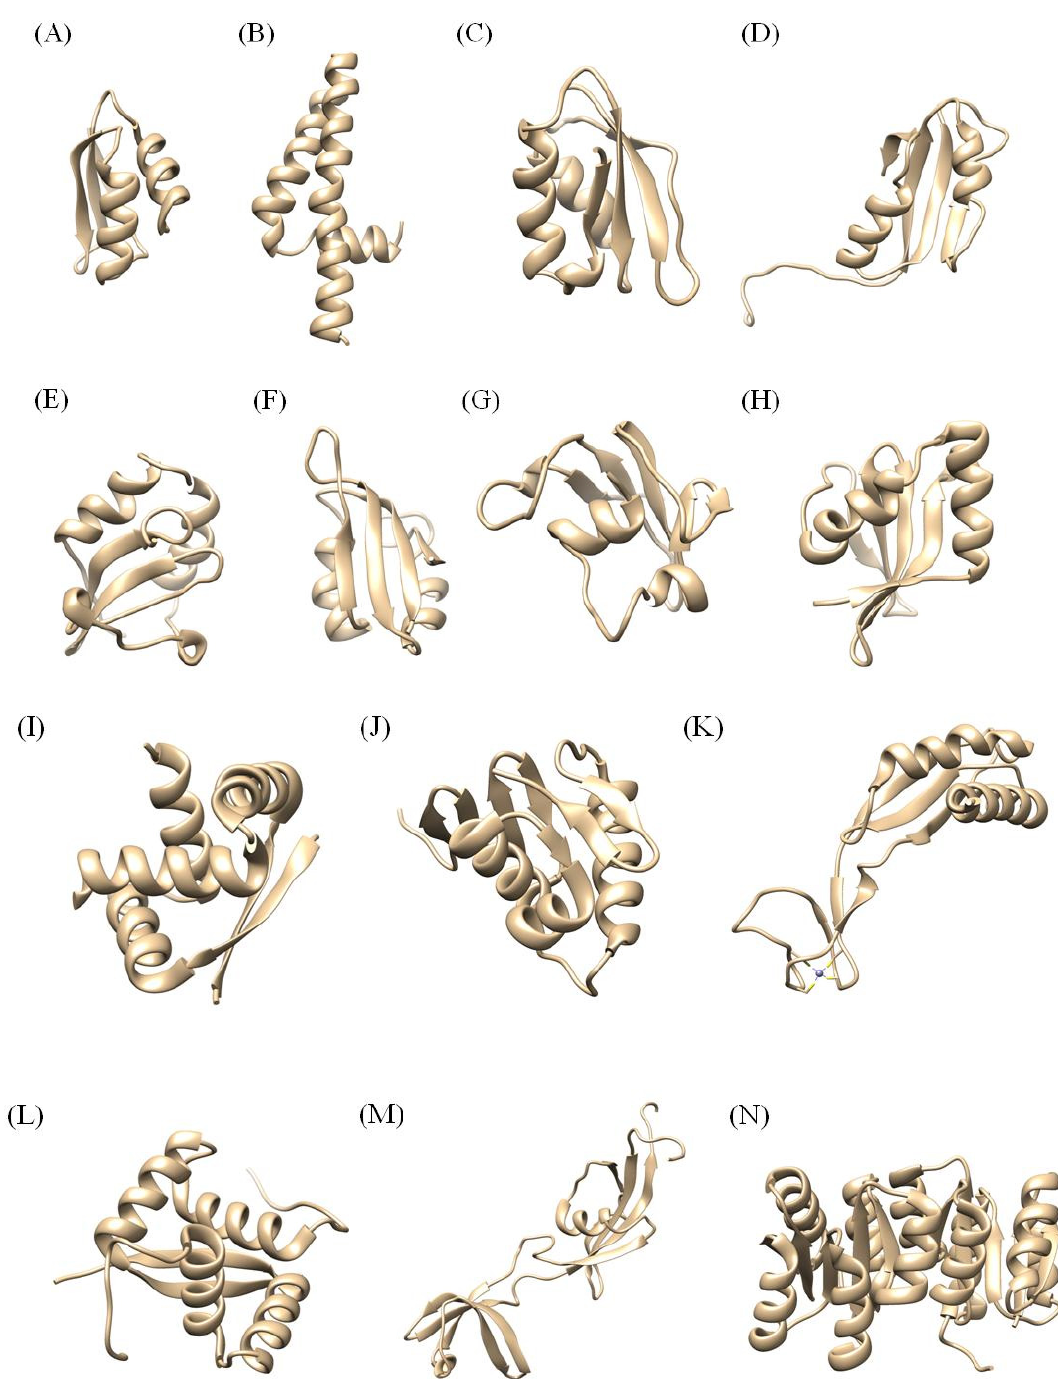
Figure 3. Structures of H. pylori proteins determined by NMR. ( A ) 1YG0